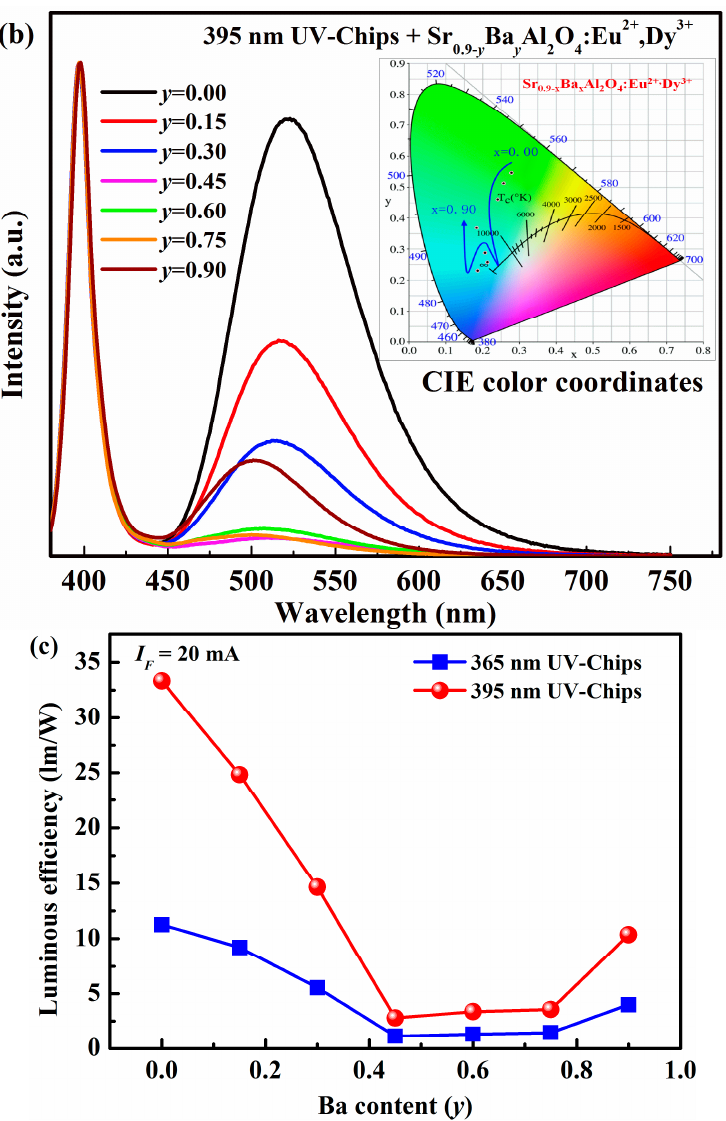
Figure 6. Electroluminescence spectra of the as-fabricated LEDs based on UV-chip and Sr 0.90 − y Ba y Al 2 O 4 :0.05Eu 2+ , 0.05Dy 3+ phosphors under 20 mA forward-bias current (i.e., I F = 20 mA). Inset is chromaticity diagram of the as-fabricated LEDs: ( a ) 365 nm UV-chip; ( b ) 395 nm UV-chip; ( c ) Luminous efficiency of as-fabricated LEDs with different Ba 2+ content under I F = 20 mA. Table 4. Parameter of chromaticity coordinates based on Sr 0.90 − x Ba x Al 2 O 4 :0.05Eu 2+ , 0.05Dy 3+ phosphors with 365 nm and 395 nm UV-Chips under 20 mA forward-bias current. 395 y Values